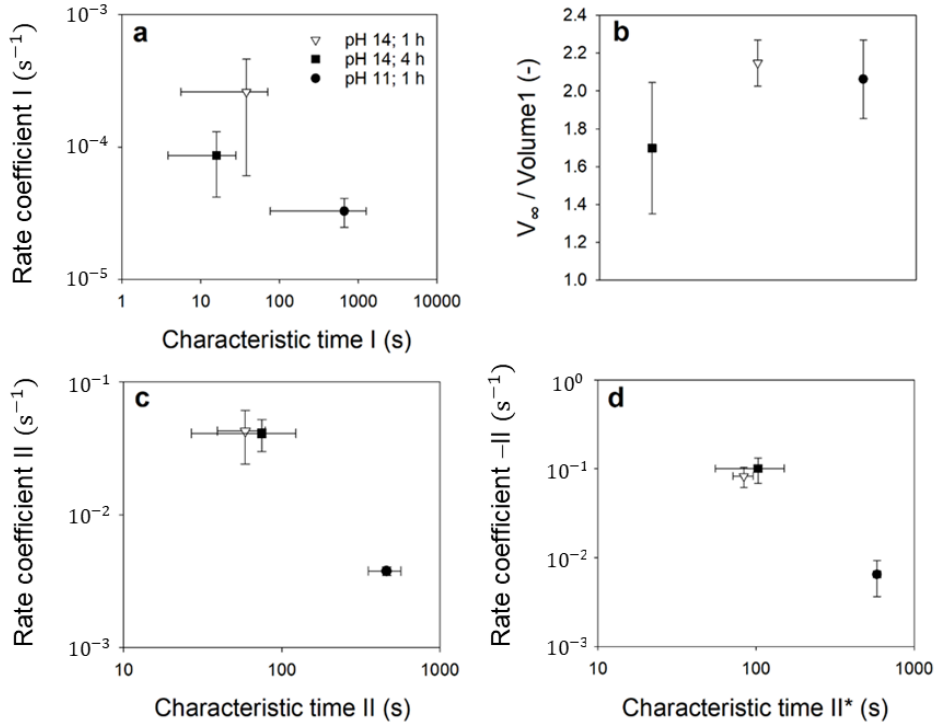
Figure 6. Values of the parameters, which determine the volume curves in Figure 5 via the rates of volume change: Rate coefficient versus characteristic time ( a ) and relative equilibrium swelling volume ( b ) for the uncross-linked casein and rate coefficient versus characteristic time for the swelling ( c ) and deswelling ( d ) process of the cross-linked caseins. Vertical and horizontal error bars correspond to the standard deviation.